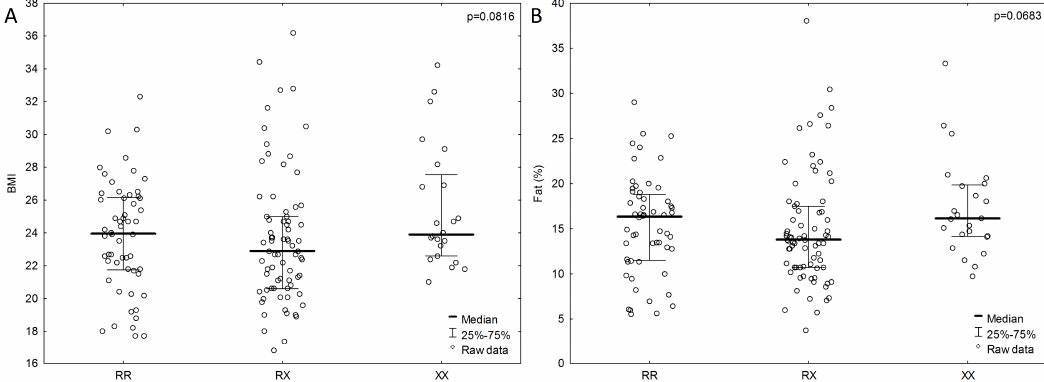
Figure 2. BMI ( A ) and percentage of fat levels ( B ) associated with ACTN3 gene polymorphism in male group. P values from ANOVA (analysis of variance) Kruskal-Wallis test.